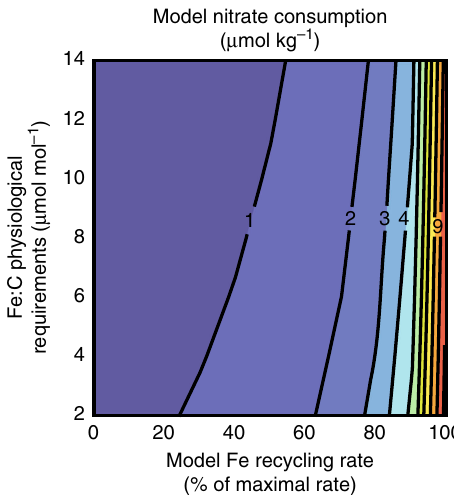
Fig. 5 Sensitivity analysis of model nitrate consumption. Modeled nitrate consumption at 200 model days as a function iron recycling rate ( X -axis) and iron: carbon (Fe:C) physiological requirement ( Y -axis). With no iron recycling and a Fe:C requirement of 12.3, the model predicts nearly identical nitrate consumption as the stoichiometric calculation using observed values and/or decreasing the Fe:C physiological requirement increases the predicted nitrate consumption. The maximal iron recycling rate considered is based on optimized model settings (see “ Methods ”